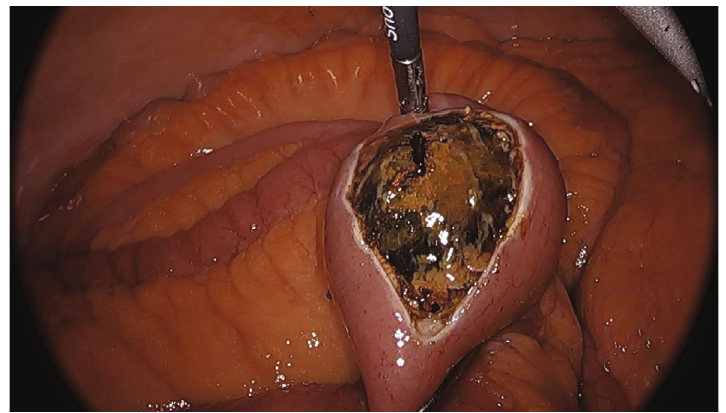
Figure 2: Enterotomy with large gallstone exposed.